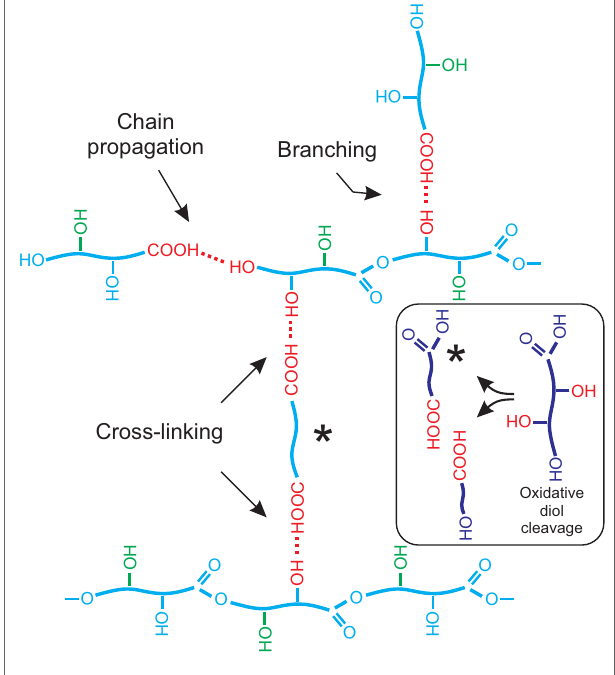
FigUre 7 | scheme representing chain propagation, branching, and cross-linking in the structure of a polyhydroxyester resulting from monomers bearing a primary and a secondary hydroxyl (poly dihPa, blue) and one primary and two vicinal secondary hydroxyls (poly trihPa, blue plus green) . In this later case, the oxidative vicinal diol cleavage reaction is shown as an